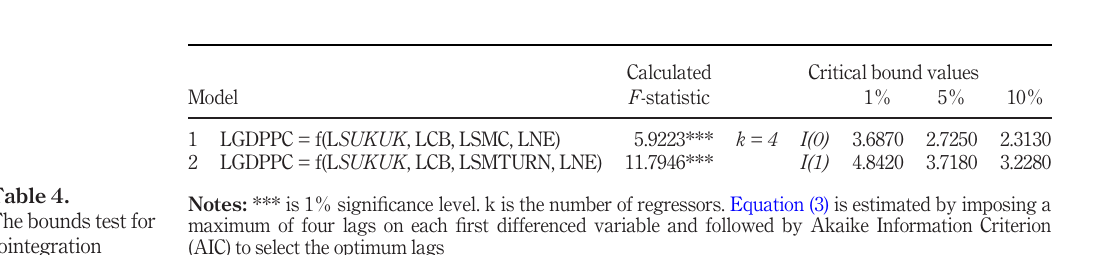
Table 3. Unit root tests